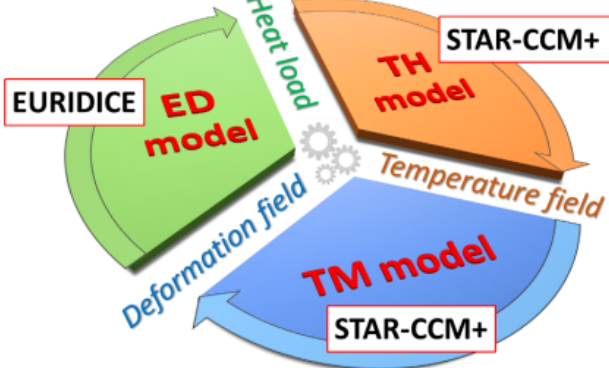
Figure 3. Structure of the MUCCA tool, with the TH, TM and ED modules highlighted, together with their interactions. The software used for the different modules is also reported.